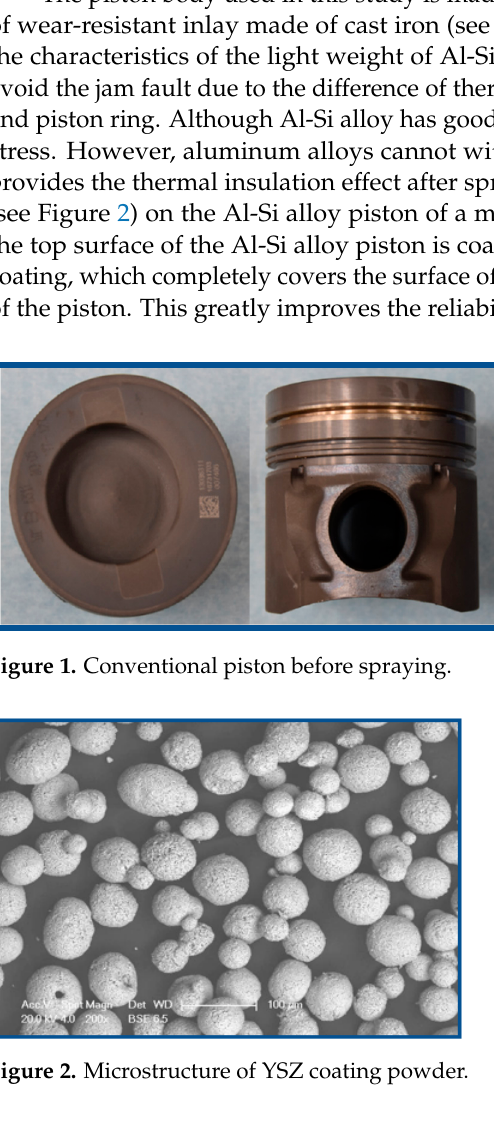
Figure 3. YSZ coated piston before and after test. Due to its simple operation and high preparation efficiency, plasma spraying equip- ment is used in the preparation of most thermal barrier coatings [13–17]. The YSZ ceramic coatings are used as thermal insulation coatings because of their low thermal conductivity and relatively high coefficient of thermal expansion, thereby reducing harmful coating interface stress. In this study, a two-layer thermal barrier coat- ing system with a thermal barrier layer and bonding layer was used (see Figure 4). The top coating comprises a 300 mm thick YSZ ceramic. The second layer is a bond coating containing a 100 mm thick NiCoCrAlY compound (see Figure 5). Figure 4. Thermal barrier coating piston model. Figure 5. The half piston model and thermal barrier coating thickness.